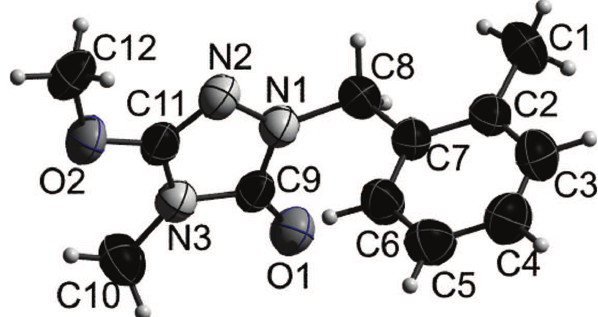
Table 1: Data collection and handling.